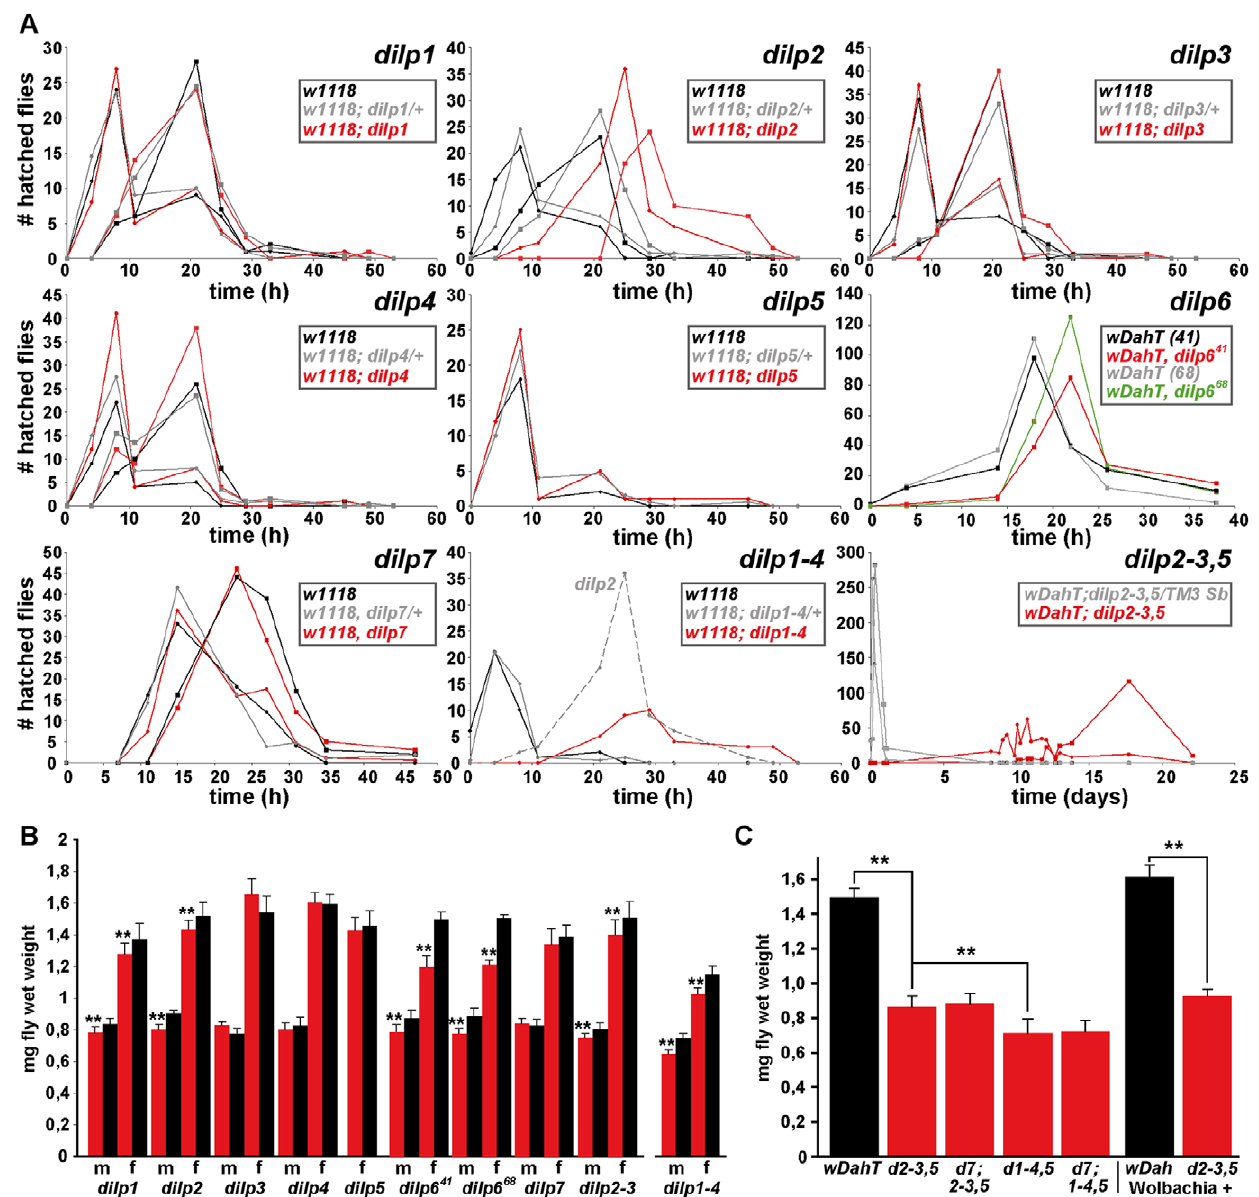
Figure 4. Development time and body weight of dilp mutants. (A) Egg-to-adult development time of dilp mutants. Only the hatching period of the adult flies is shown. Rectangle: males (m), circle: females (f). (Note: number of heterozygous flies was halved to adjust to the number of homozygous and w control flies.) (B) Body weight of dilp mutant (red) males (m) and females (f) compared to controls (black). (n=20 flies). (C) Body weight of female flies that lack multiple dilp genes. (n=40 f; dilp1–4,5 n=20 f; dilp7,1–4,5 n=18 f). Wolbachia + flies (w Dah ) weigh more than Wolbachia - flies (w DahT ). Body weight in (B,C): w DahT background, except for dilp1–4 mutants: w 1118 . ** p , 0.01, t-test.